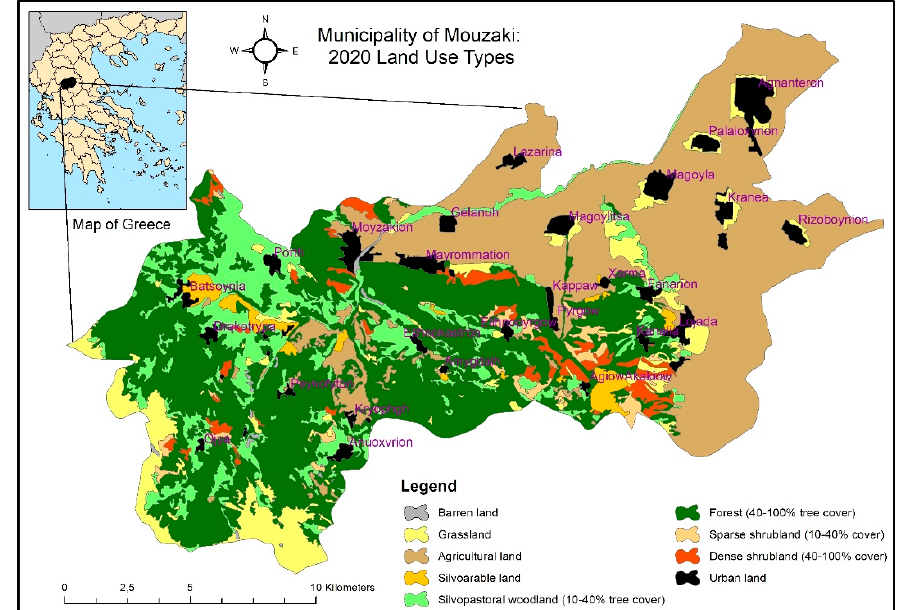
Figure 1. Land use map of Mouzaki Municipality, Greece for 2020.